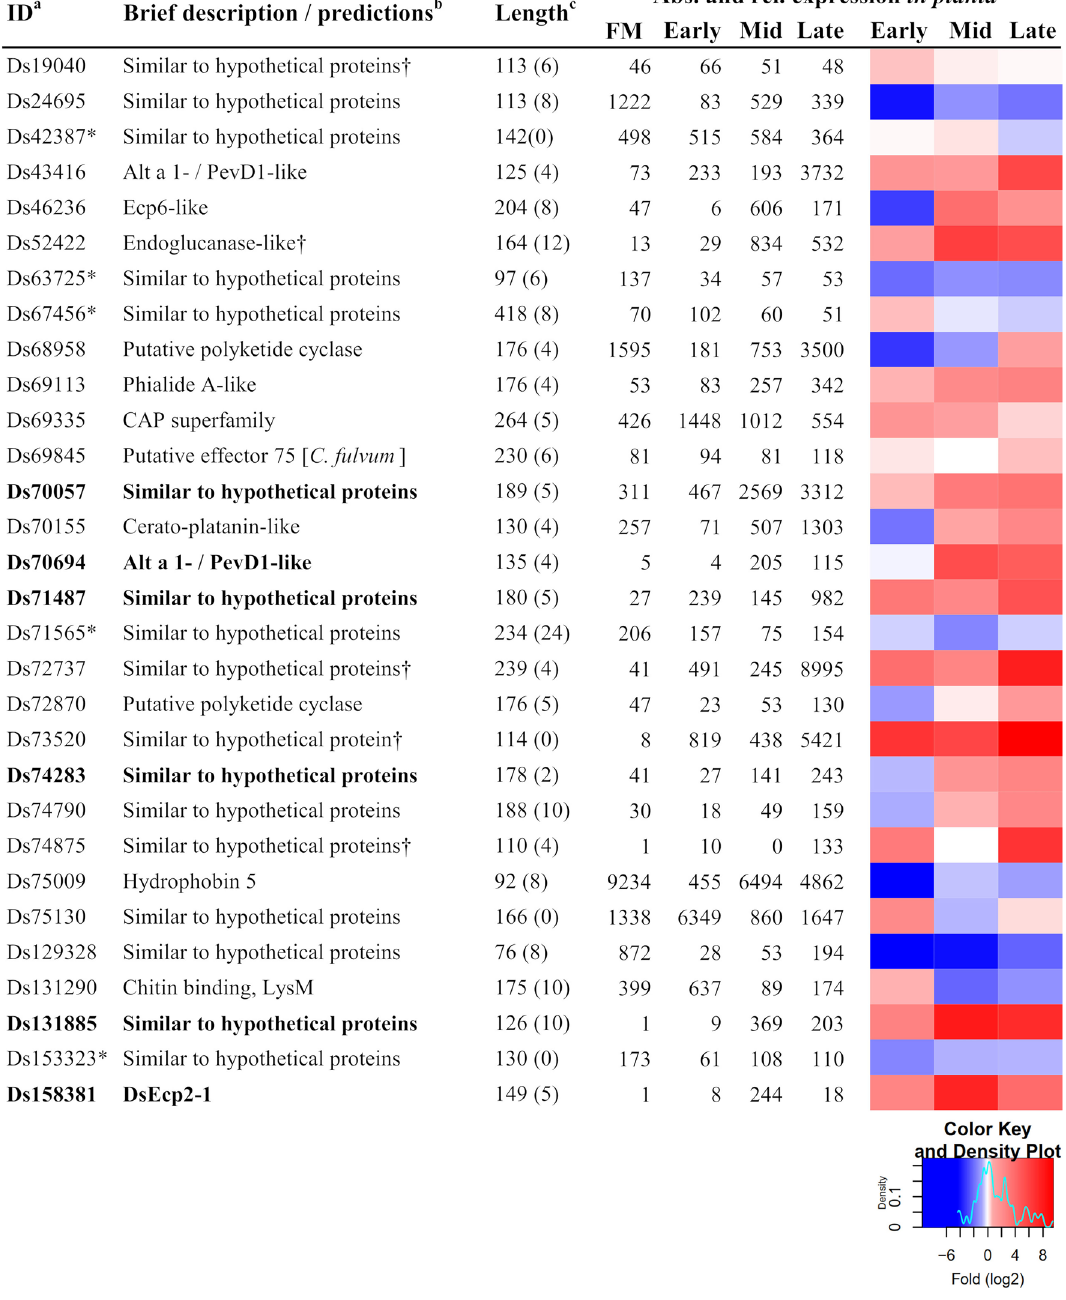
cases, structural relationships inferred from HHpred corroborated functional annotations that were previously predicted for several DsCEs based on sequence similarity (Supplementary Table S1).